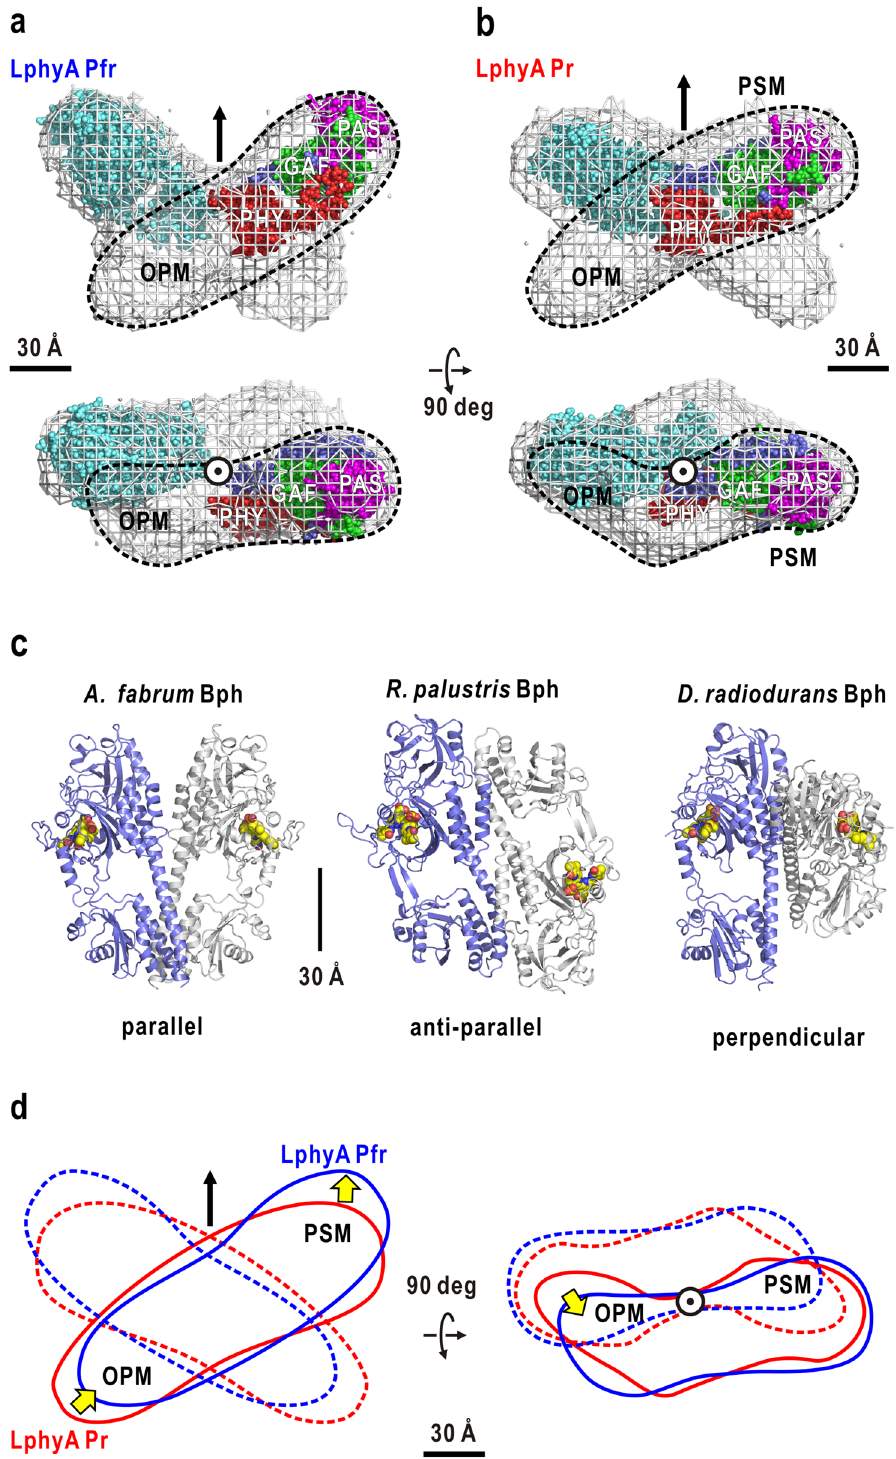
Figure 5. Most probable molecular models of the LphyA dimer in Pfr ( a ) and Pr ( b ). Averaged molecular shapes from Fig. 3 are illustrated as gray mesh. The dashed circles indicate one subunit. Subunit A in the crystal structure of PSM dimer from A. thaliana phyB (PDB accession code: 4OUR) is fitted to PSM volumes in each averaged model. The arrow in the upper panel and symbol in the lower indicate the two-fold symmetry axis in the dimer. Panels ( a , b ) were drawn using PyMol 56 . ( c ) Three types of association modes of PSM of Bph and phyB in their crystal structures. Two subunits are distinguished by the colors of the models. ( d ) Schematic illustration of structural changes in Pr/Pfr photoconversion. Yellow arrows indicate movements of the functional